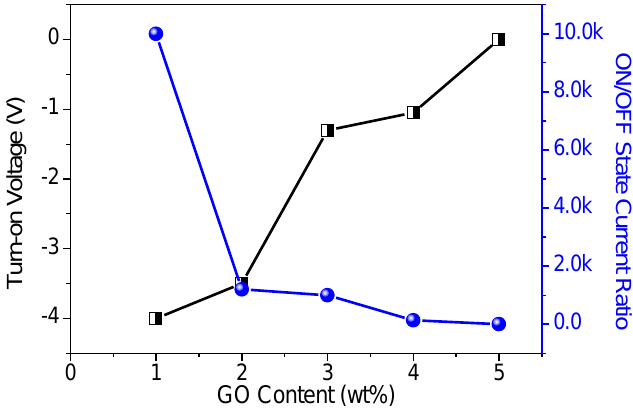
Figure 8. Effect of the GO content on the turn-on voltage and the ON/OFF state current ratio in memristic